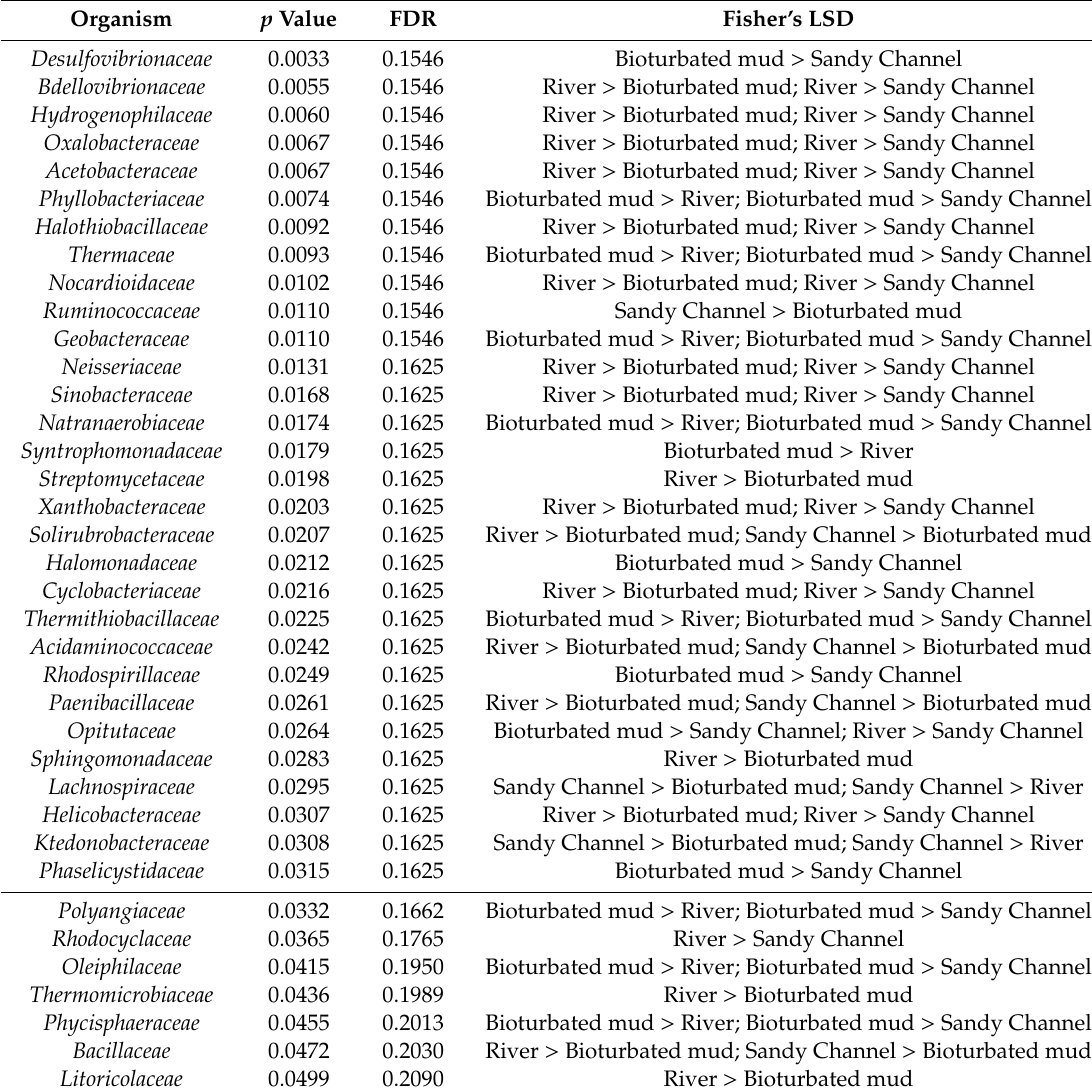
Table 6. Summary of taxonomic classification based on habitat bacterial 16S sequencing data from Moreton Bay marine sediment using one-way ANOVA analysis.